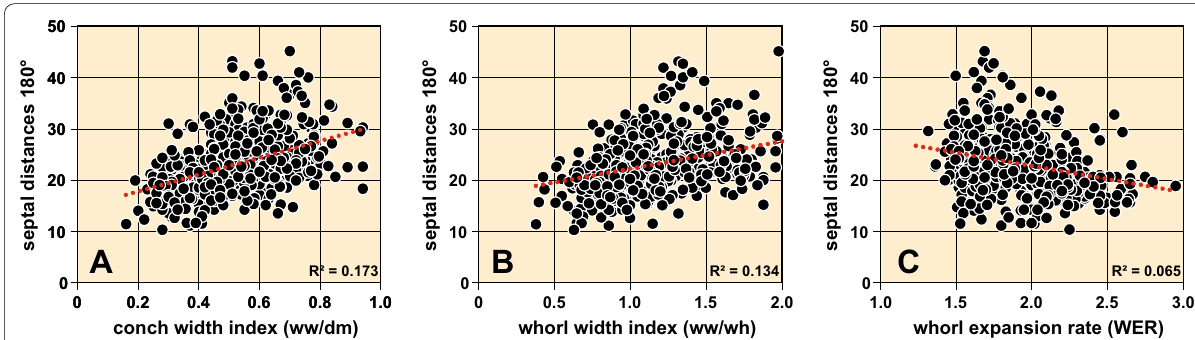
Fig. 8 Bivariate plots conch parameters and septal spacing (of the last half volution) of all analysed specimens. A Conch width index (ww/dm) and septal spaces. B Whorl width index (ww/wh) and septal spaces. C Whorl expansion rate (WER) and septal spaces